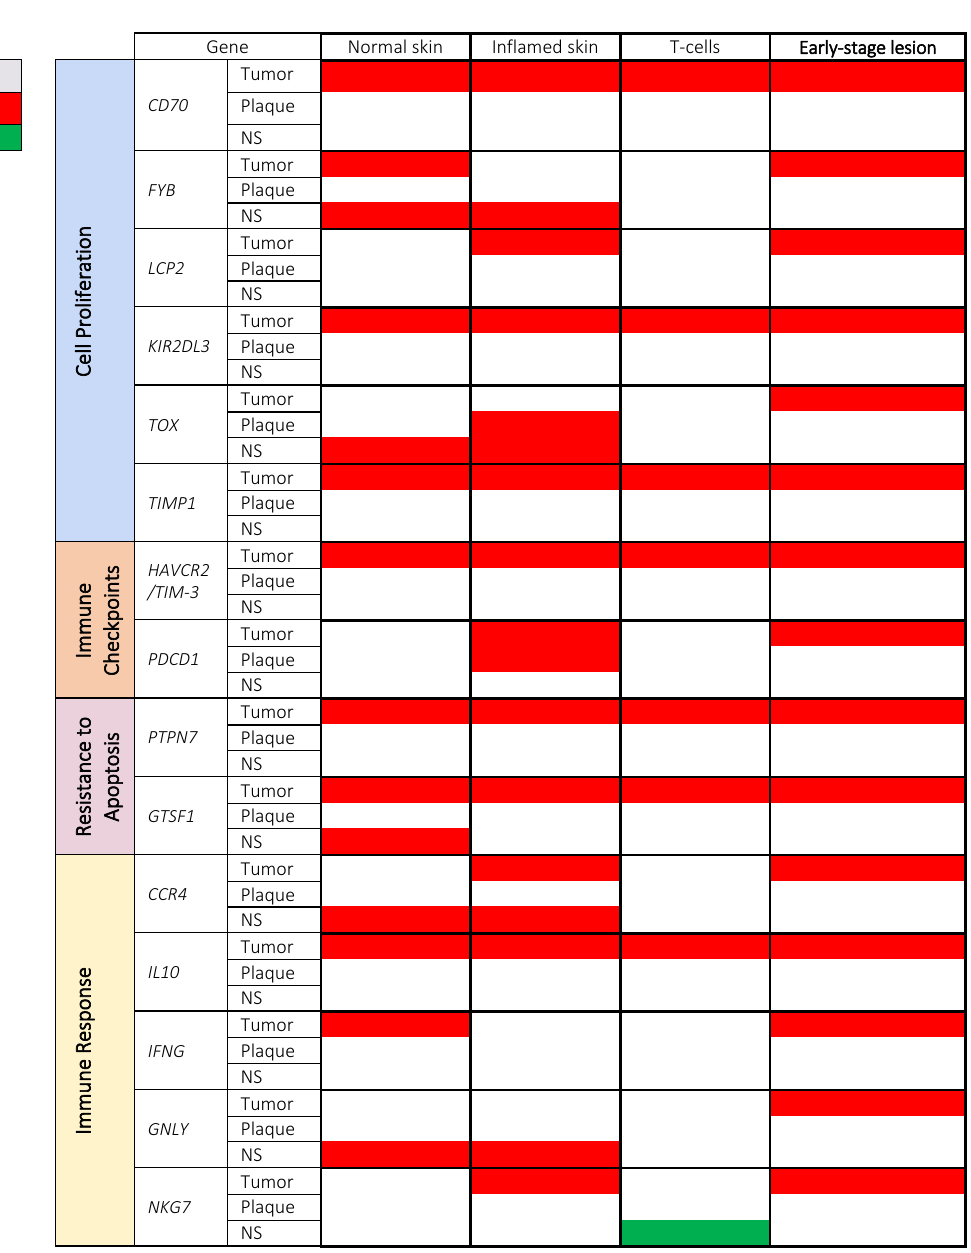
Figure 3. Genes involved in disease progression. A total of 15 genes were increased from early stage to late stage of MF which corresponded to genes involved in cell proliferation and activation, immune checkpoints, resistance to apoptosis, and immune response. Additional data from tumor, plaque, and NS samples against various controls (normal skin, inflamed skin, and T-cells) are represented to provide more detailed comparison regarding these 15 genes implicated in disease progression. Abbreviations: NS,